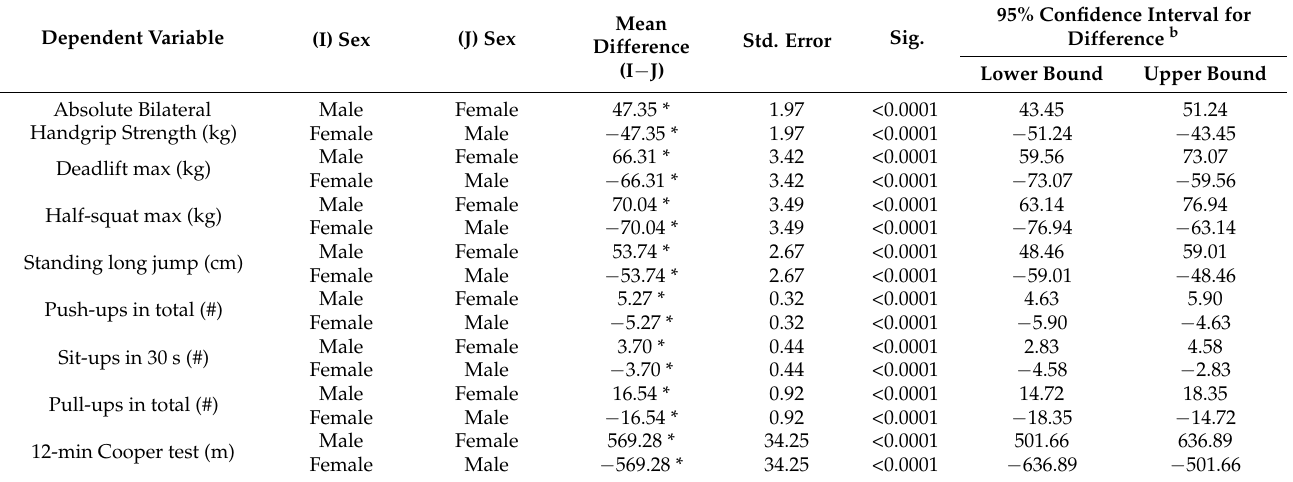
Table 4. Sex Pairwise Comparisons.